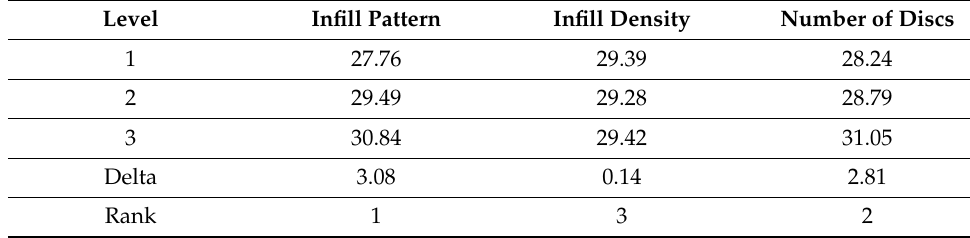
Table 7. Response Table for SN ratios of PLA samples.